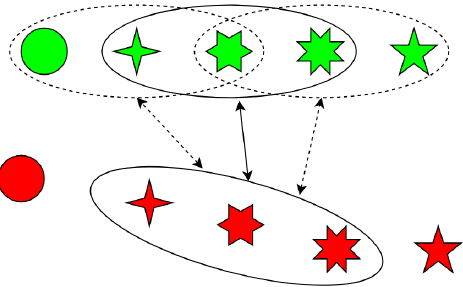
Figure 9: Neighborhood stock matching candidate details: refer- ence data in green, and target data in red, each objects represents a vine